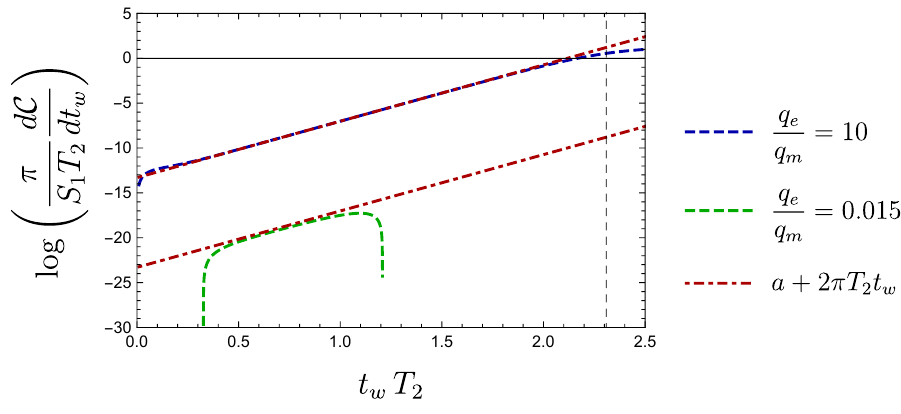
Figure 5 . The exponential growth for the complexity with a light shock wave, such that r + ; 2 = (1+10 (cid:0) 6 ) r + ; 1 , and also with L = 0 : 5 r + ; 2 , r (cid:0) ; 1 = 0 : 5 r + ; 2 , l ct = L . We show two examples, one for a black hole with mostly electric charge (cid:31) = 10 and one with mostly magnetic charge (cid:31) = 0 : 015. For the larger (cid:31) , the dynamics is well approximated by an exponentially growing mode with Lyapunov exponent (cid:21) L = 2 (cid:25)T until times of the order of the scrambling time (vertical black line), as in eq. (2.40). For the smaller value of (cid:31) , the amplitude of this initial mode is suppressed both by the energy of the shock wave and by a factor of (cid:31) 2 . The exponentially growing mode only dominates at very early times because it must compete with other transient e(cid:11)ects. In the limit that the black hole has only magnetic charges (i.e., (cid:31) = 0), this exponentially growing mode is